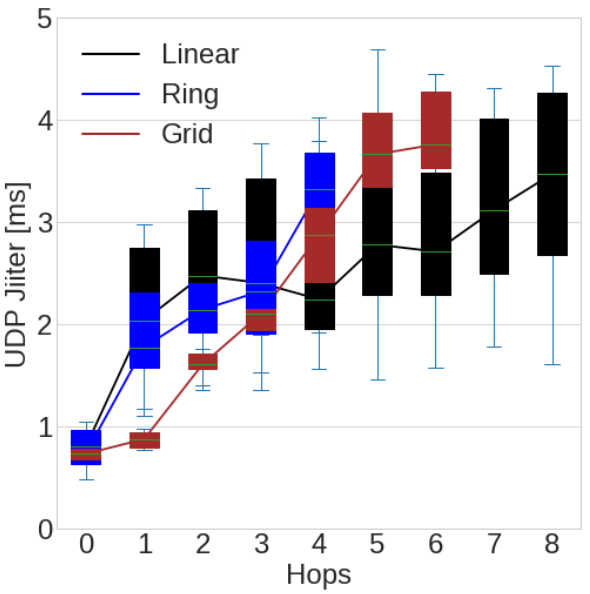
Figure 21. W-iLab1.t UDP jitter. 4. TCP and SCTP Bandwidth: TCP and SCTP bandwidth decrease as hops increase for linear, ring, and grid topology (Figure 22). Hop 1 bandwidth is not decreased much because of the use of the 5 GHz lower channel and the proximity to node 0 and node 2. See Figure 9 for understanding of the setup and relation to the results.